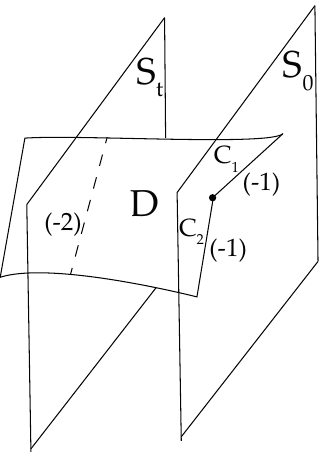
Figure 1: The splitting of flavor curve into two O ( − 1 ) ⊕ O ( − 1 ) curves.